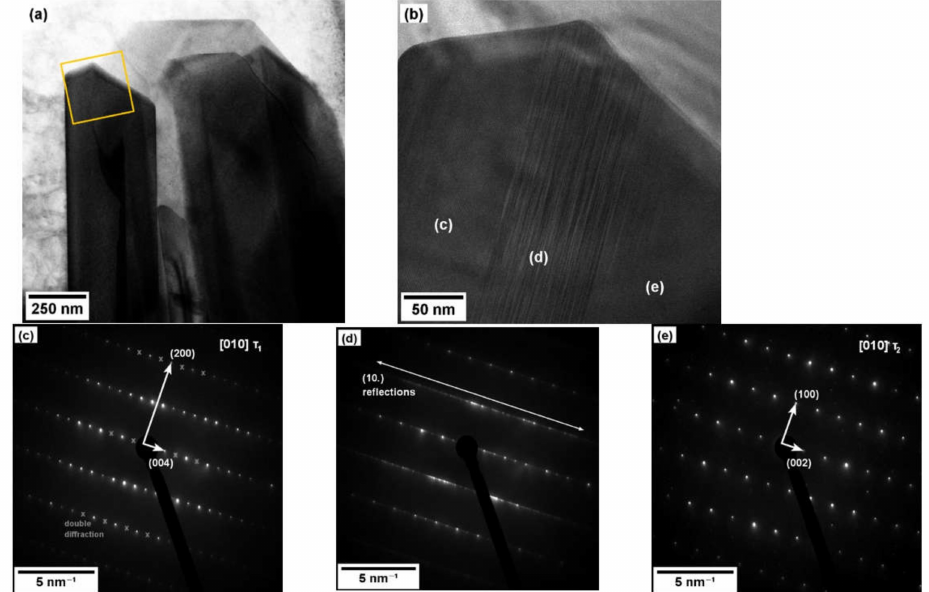
Figure 11. ( a ) BF STEM micrograph of the precipitate at the interface. ( b ) Detail of the precipitate (marked in ( a )) having three different crystal structures. ( c ) SAED from the left side of the particle in ( b ) corresponding to the τ 1 phase in [010] direction. Double diffractions are marked by grey crosses. ( d ) SAED from the central region of ( b ) with a complicated stacking sequence along c axis, creating extra {10} type reflections (blending into streaks). ( e ) SAED from the right side of the particle in ( b ) corresponding to the τ 2 phase in [010]